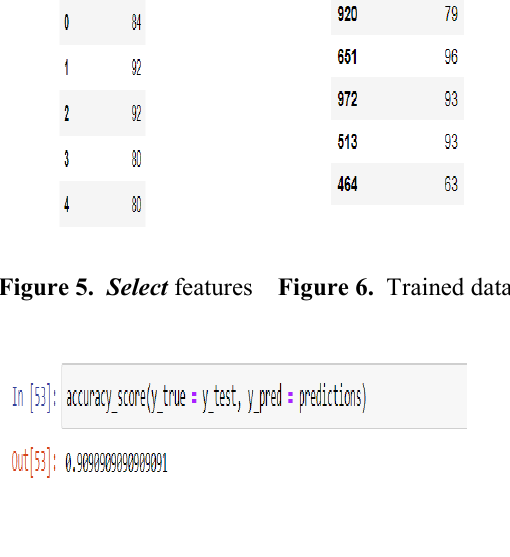
Figure 7. Accuracy measurement of decision